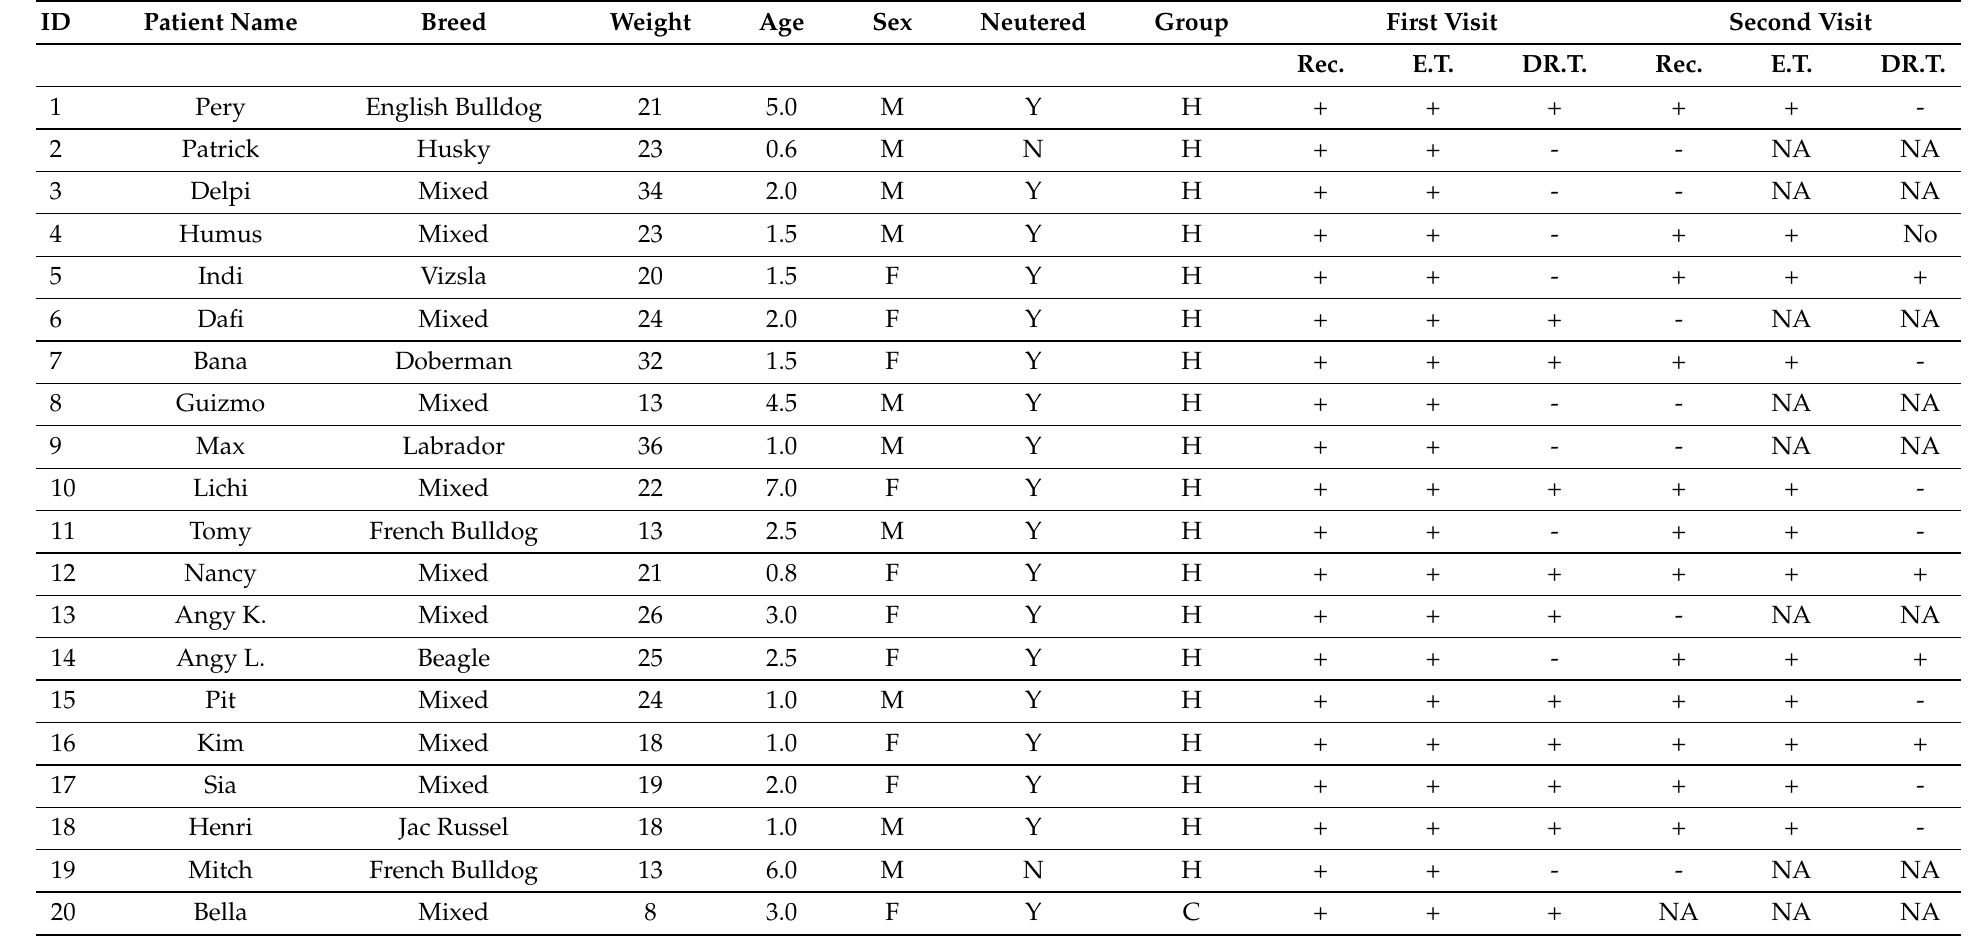
Table A1. Participant demographics and trial